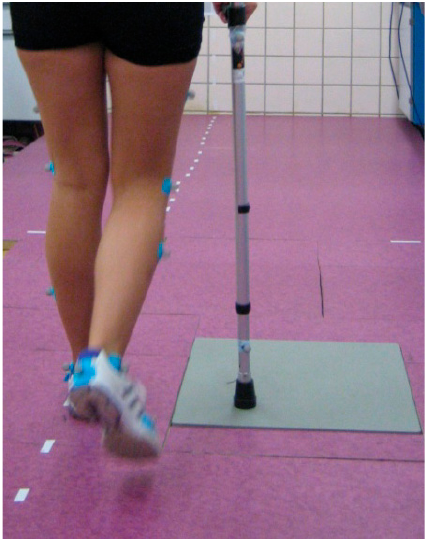
Figure 3. Individual performing aided gait in two stages along the walkway with direction signs and distracting effects so as to avoid him/her focusing on the platform.